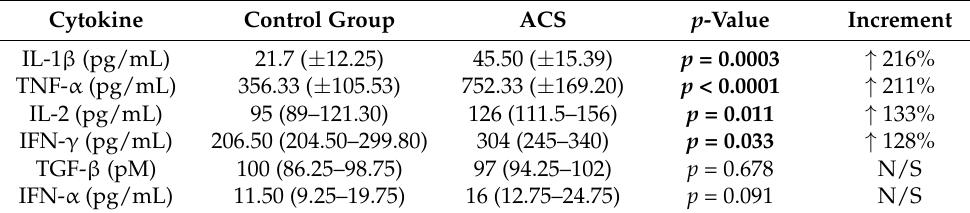
bold, while N/S means no